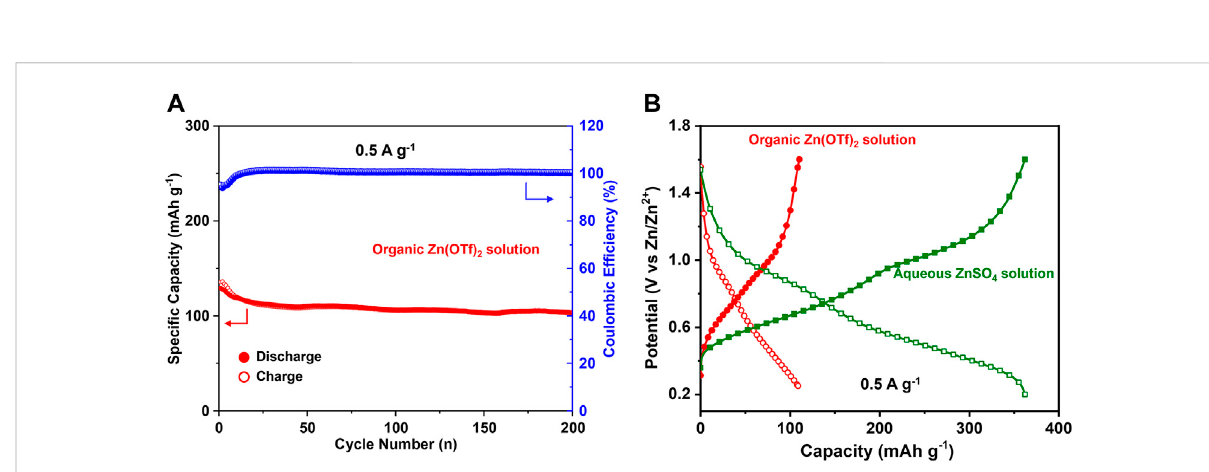
FIGURE 6 (A) Cycling performance of the V